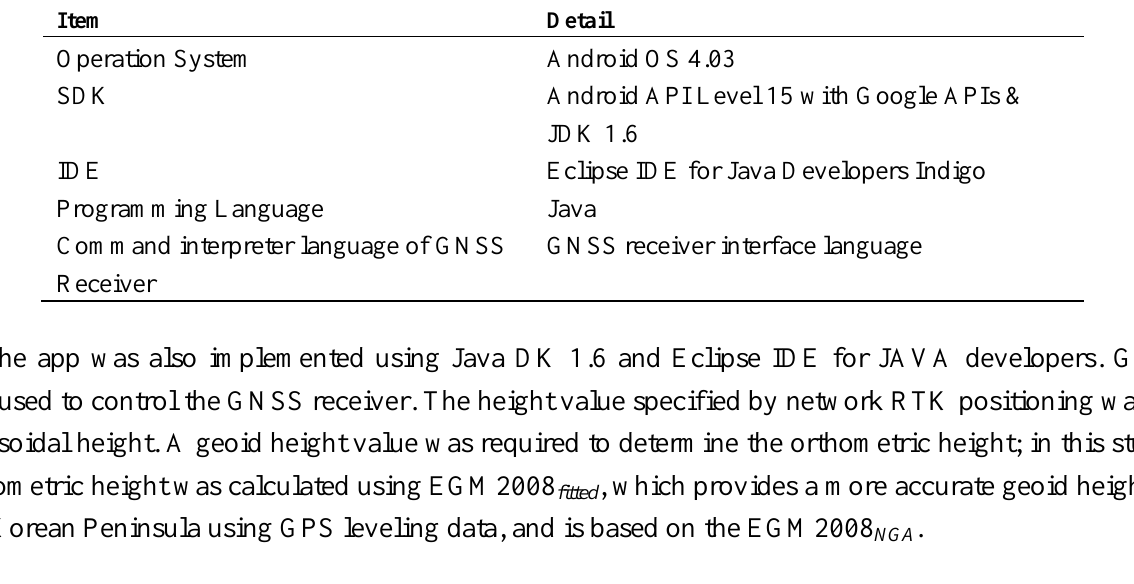
Table 2. Android OS-based app development